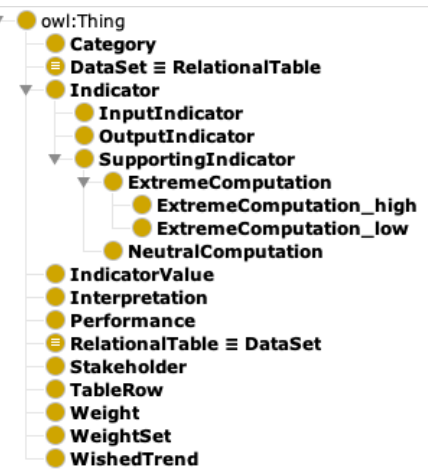
Figure 6. Main classes in Protege [43].